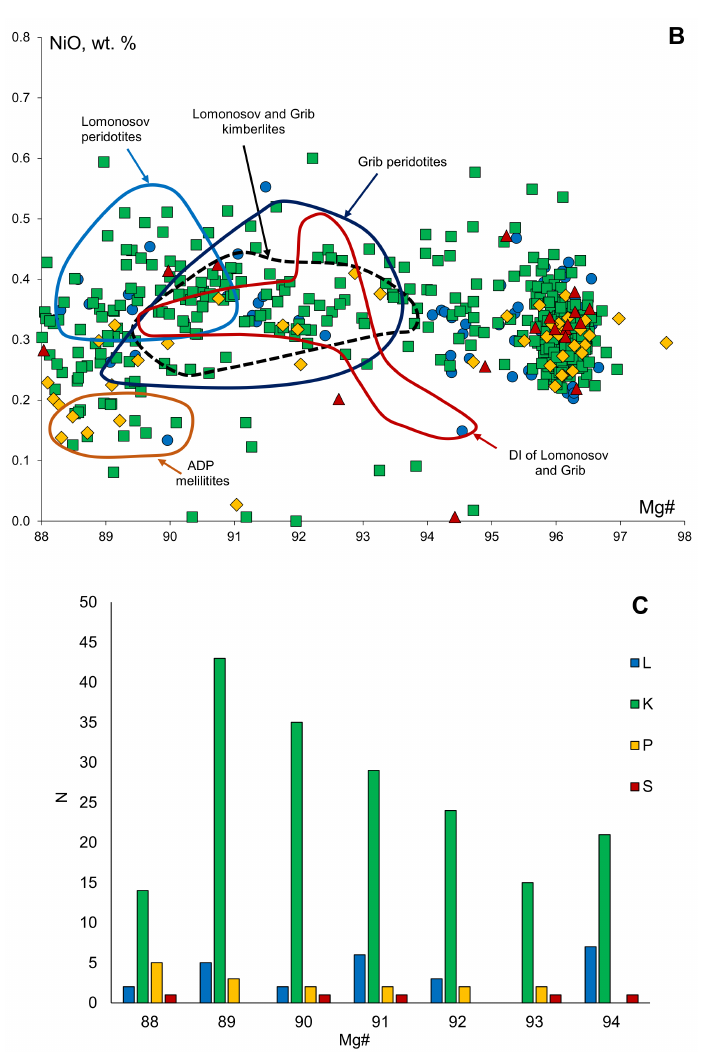
Figure 5. Major element composition of olivine. ( A ) Cr 2 O 3 –FeO diagram; ( B ) NiO–Mg# diagram; ( C ) distribution of Mg#, N, number of grains analyzed. DA, diamond association [40], Lomonosov and Grib kimberlites and peridotites [11,35,37–39], DI (inclusion in diamonds) from the Lomonosov and Grib [11,36], ADP melilitites [11].